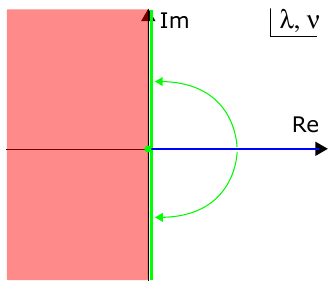
Figure 18 . Analytic continuation of the integral representation (G.20) of the modified Bessel function K ( x ). We need Re( ν, λ ) > 0 for 2 ik